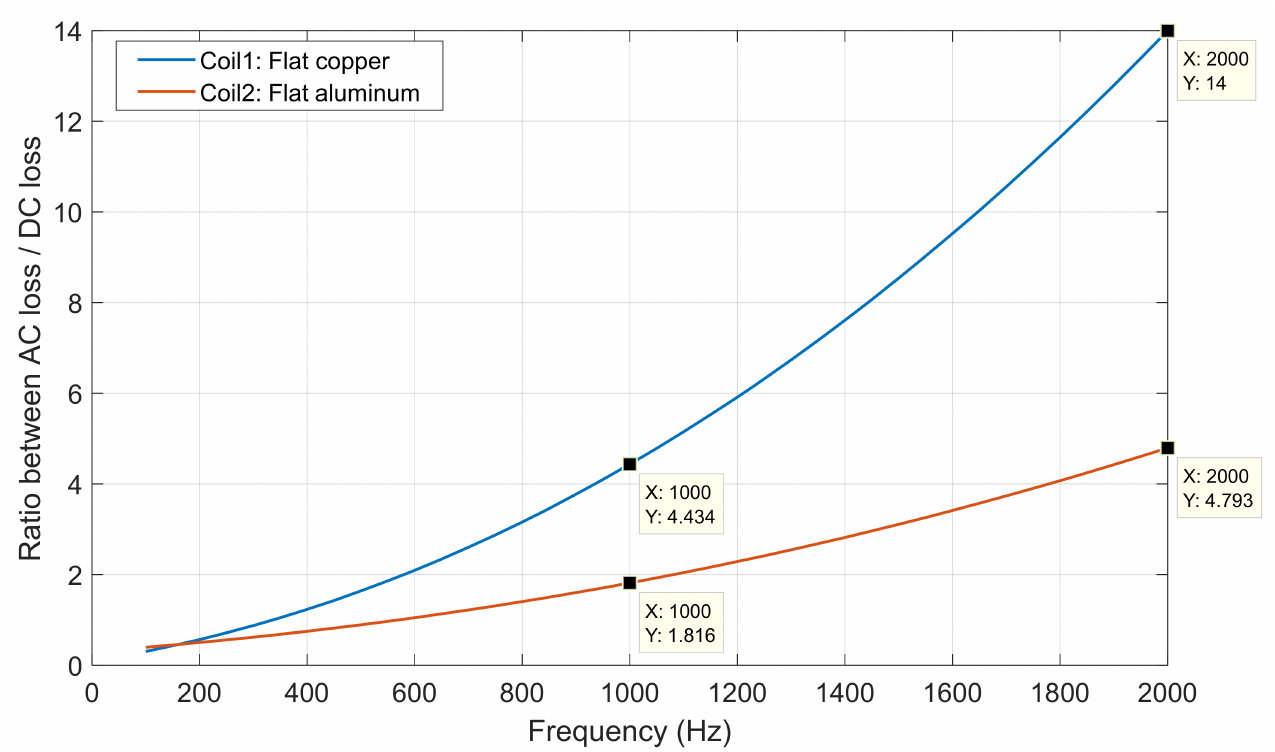
Figure 14. The ratio between the AC to DC losses at different frequency